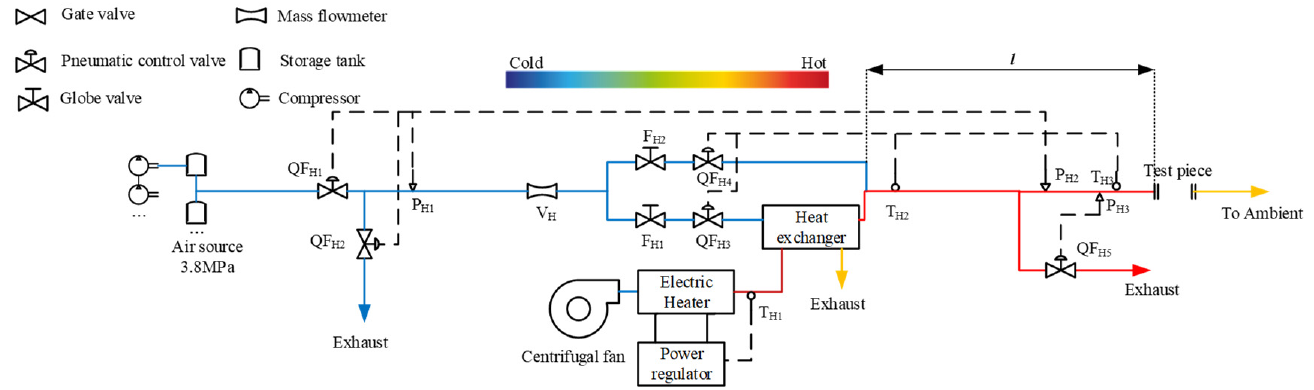
Figure 4. System flow chart of the HP ‐ stage bleed air system.